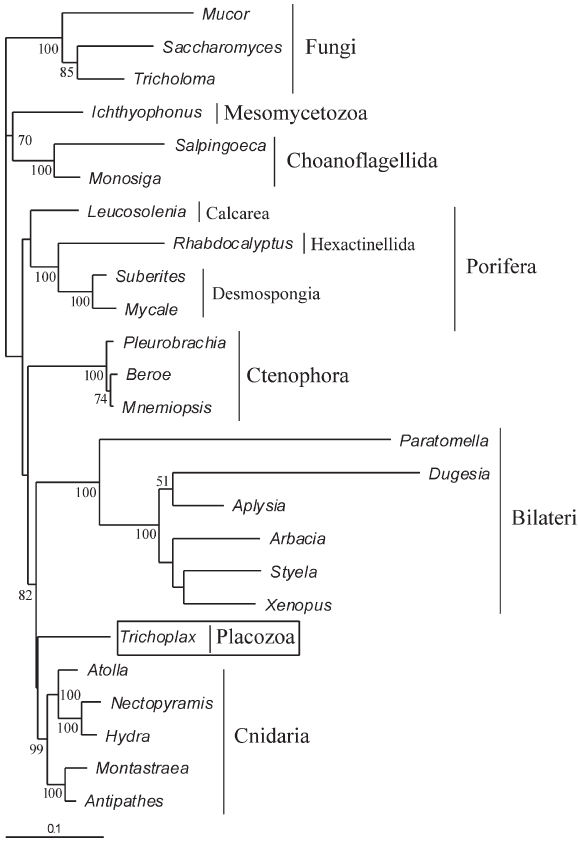
Figure 1 - Maximum likelihood large subunit (LSU) + small subunit (SSU) tree. Bootstrap values (%) are shown at the nodes. Nodes without numbers indicate values below 50.